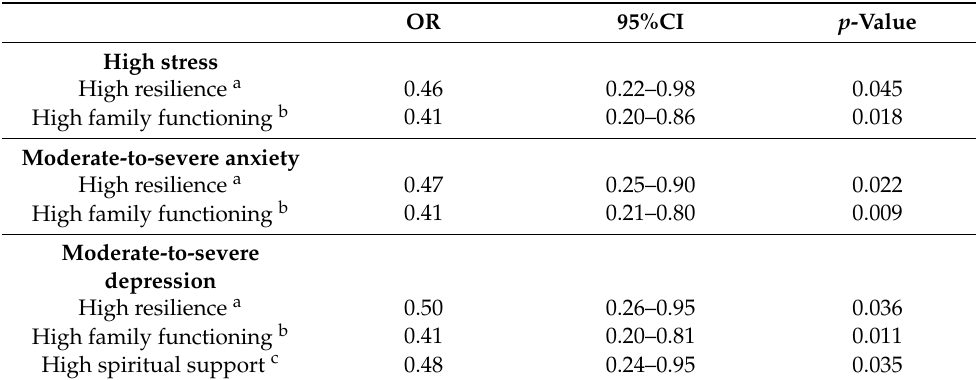
Table 2. Predictors of poor mental health during COVID-19 lockdown ( N =